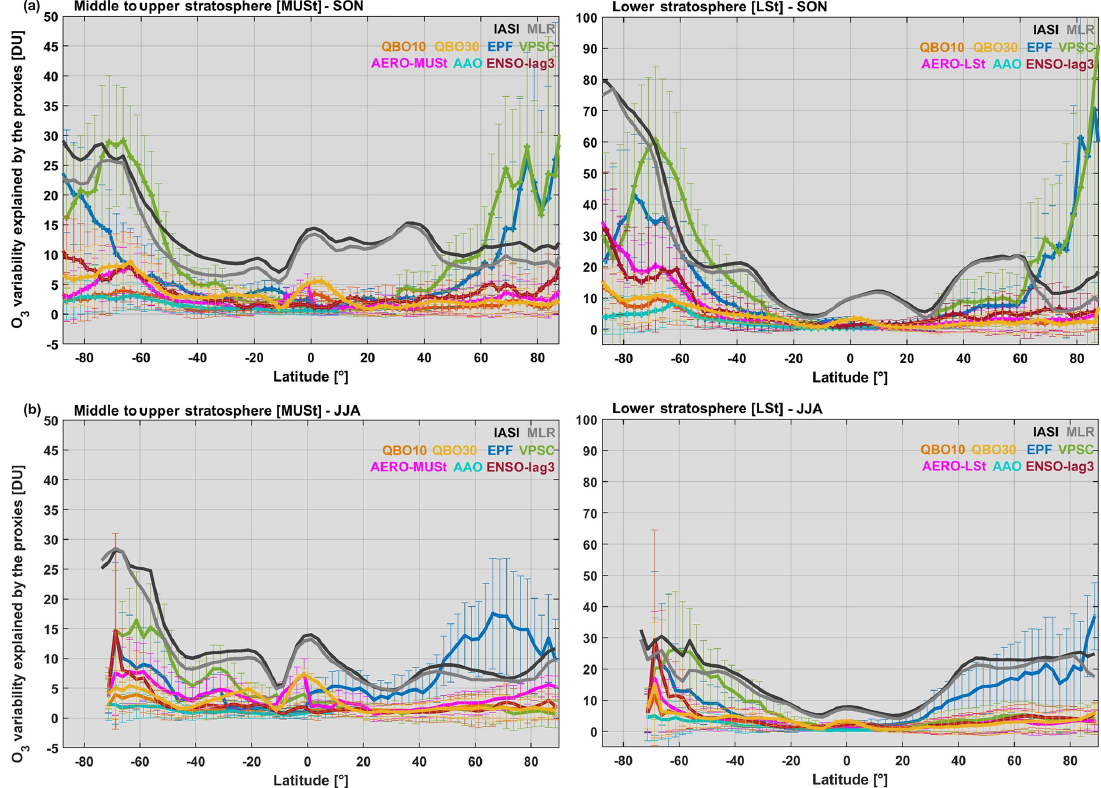
Figure 7. Same as Fig. 6b but for (a) the austral winter and (b) the austral spring periods (JJA and SON, respectively) from the seasonal MLR. Note that the scales are